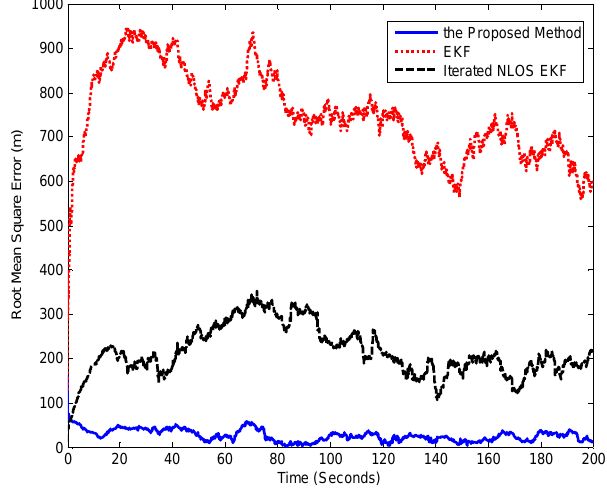
Figure 2. Comparison of the RMSE when the three FNs are all in NLOS